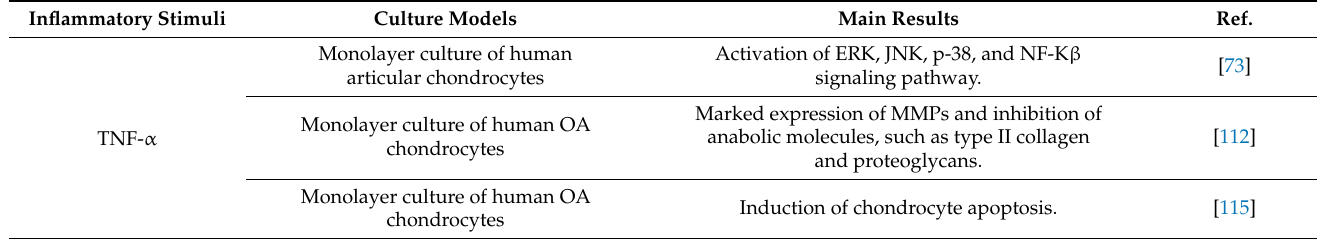
Table 1. List of inflammatory Osteoarthritis (OA) models with specific details of the nature of the inflammatory stimuli, the culture systems (2D/3D/cocultures), the main findings, and the bibliographic reference. Inflammatory Stimuli Culture Models Main Results